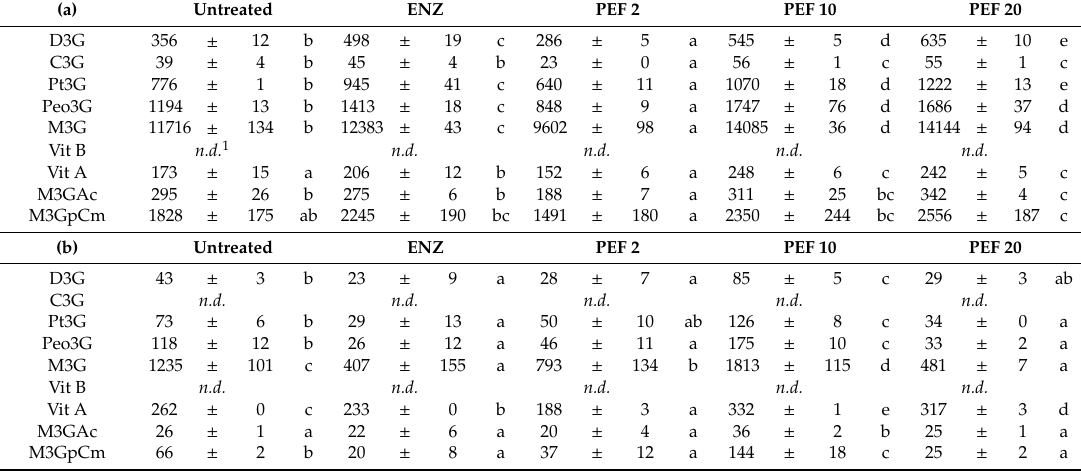
Table 4. Results of the HPLC separation of anthocyanins in the experimental wines after two ( a ) and twelve months ( b ) of bottle storage. The data reported are absolute areas / 1000 (means ± SD). Di ff erent letters mark significant di ff erences according to ANOVA and Tukey HSD test ( p < 0.05). Refer to Table 1 for sample codes.